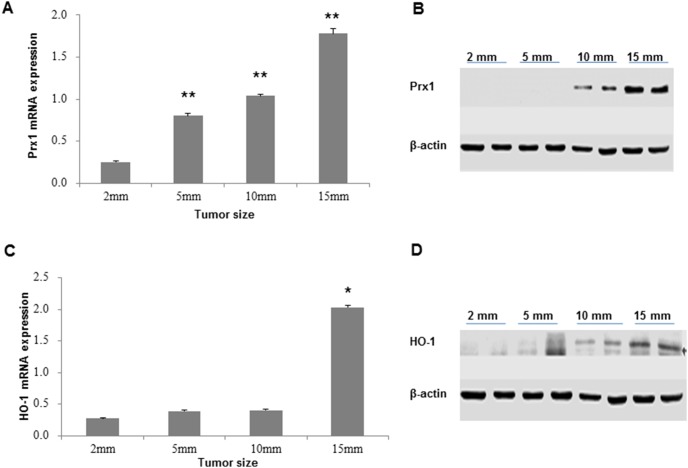
Expression of Prx1 and HO-1 in xenograft tumors.A and C, mRNA expression of Prx1 and HO-1 detected by qRT-PCR. B and D, Protein expression of Prx1 and HO-1 detected by western blot. *P<0.05; **P<0.01.